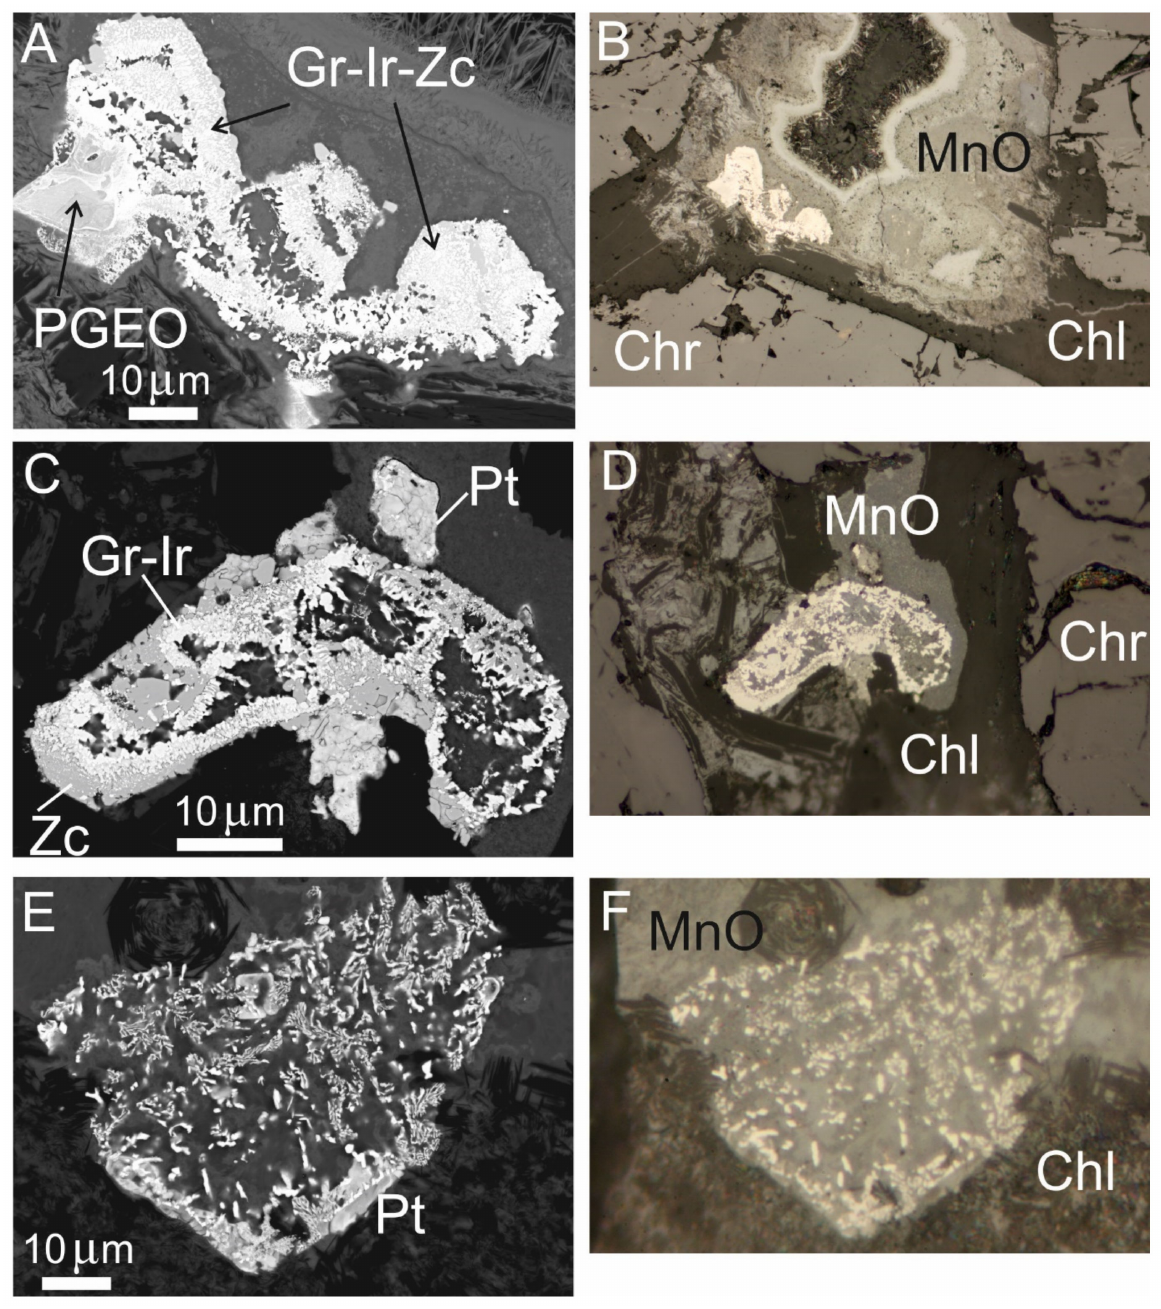
Figure 14. FE-SEM images ( left row ) and reflected-light optical microscopic images ( right row ) show- ing secondary PGM that occur associated with the interstitial chlorite and Mn-Cr-Fe-Ni hydroxides from the high-Al chromitite of Sebuku Island. Grains with an irregular and complex shape ( A – D ) and sponge-textured PGM grain composed of iridium rimmed by an alloy of Pt-Fe-Cu ( E , F ). Abbrevia- tions: Chr—chromite, Chl—chlorite, Ir—iridium, Gr—garutiite, Zc—zaccariniite, PGEO—compound of Ru-Mn-Os-Ir-Fe-O, Pt—platinum